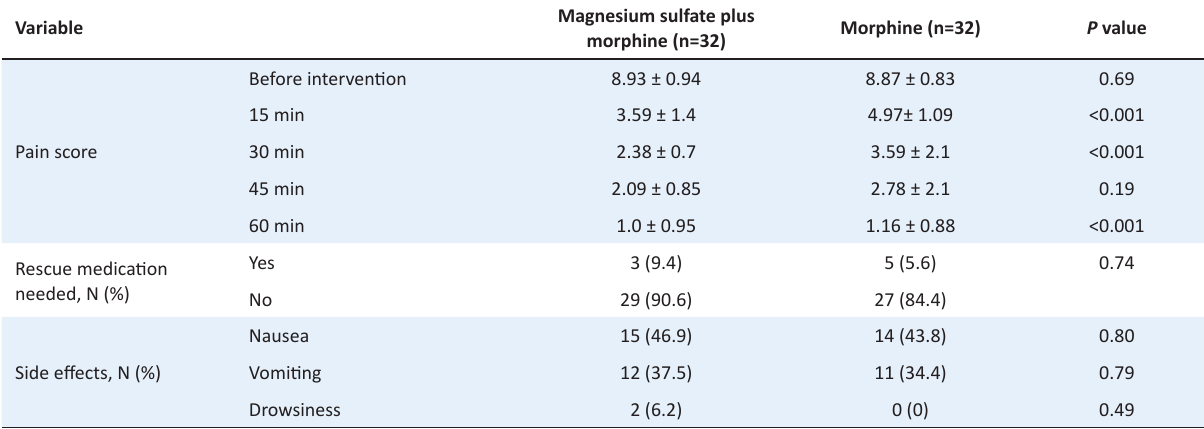
Table 2. Comparison of drug efficacy between the study groups